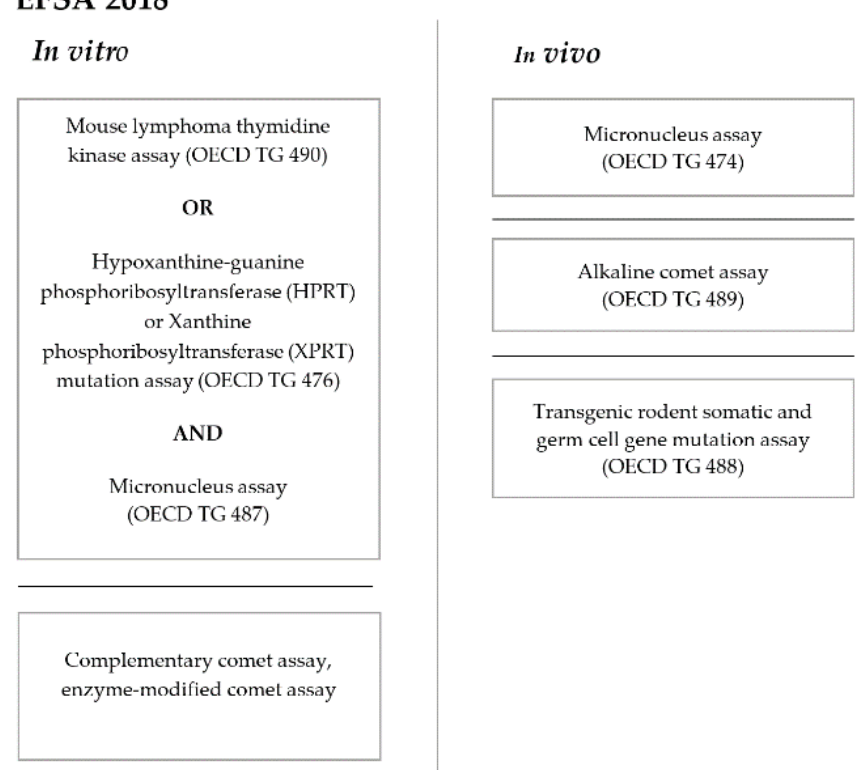
Figure 2. Scheme of the EFSA 2018 strategy for a genotoxicity assessment of NPs.